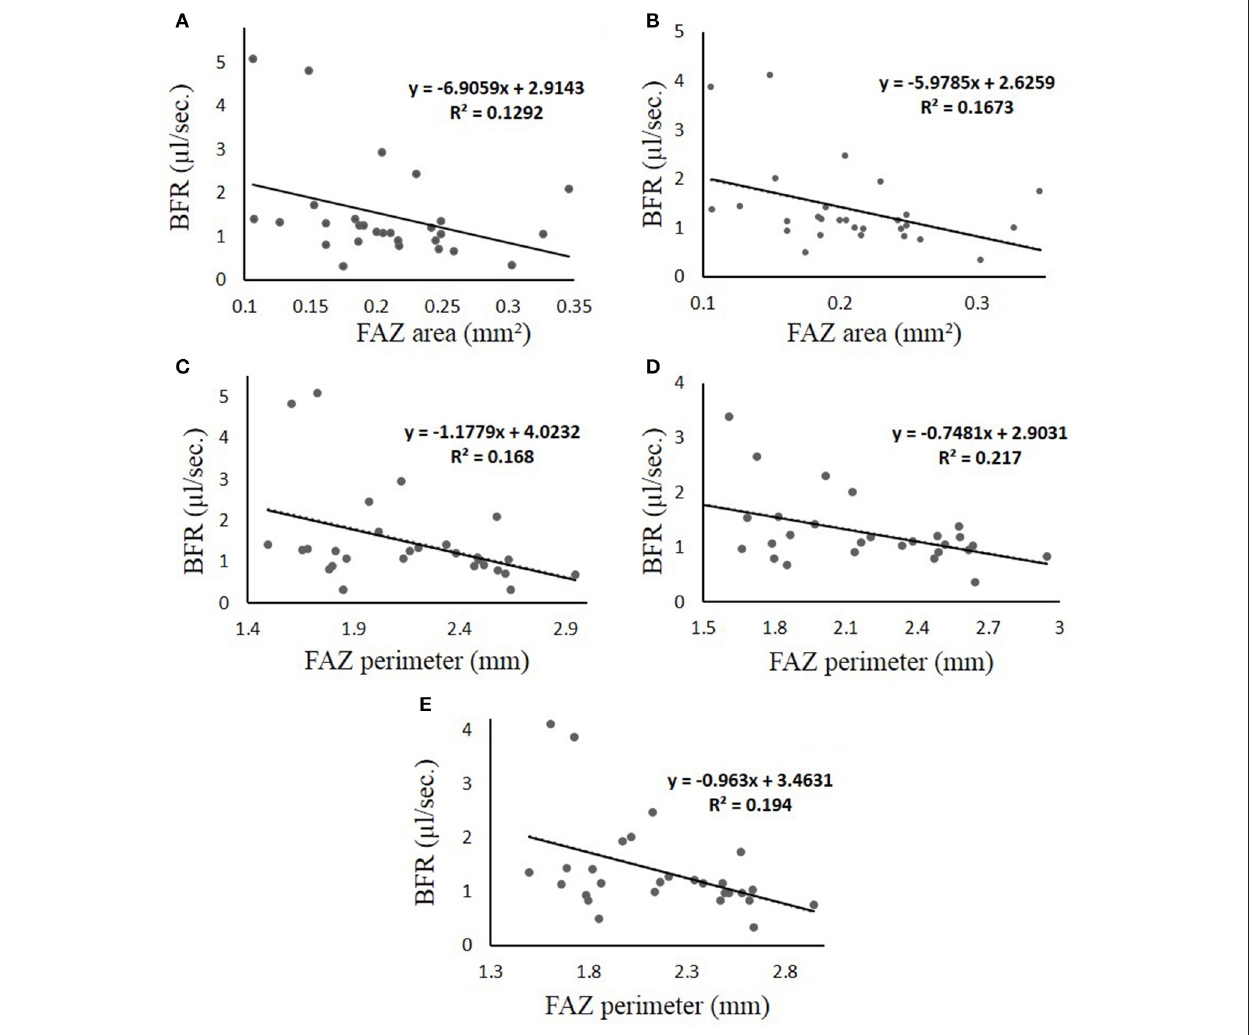
FIGURE 5 | (A–E) Linear regression results obtained for the DM group of patients, which is the only group that displayed significance when comparing the BFR to the FAZ characteristics. Each figure is labeled with measured parameters. The line represents thel ine of best fit, of which the equation is displayed in the graph region. In all cases, the “y-axis” represents BFR in µ l/s and the “x-axis” represents FAZ area in mm 2 . (A) BFR vs. FAZ area in veins (B) BFR vs. FAZ area in all vessels (C–E) BFR vs. FAZ Perimeter for arteries, veins, and all vessels, respectively. The R 2 is the coefficient of determination, which compares the ratio of the average difference of the data point and the line of the best fit with that of the data point and the average “y”